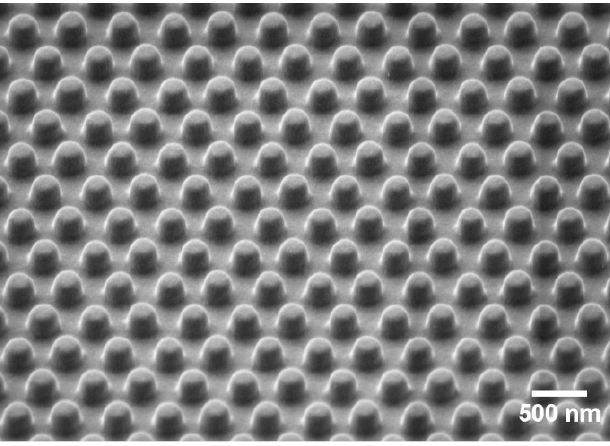
Figure 1. Scanning electron microscope image (SEM) of the nanostructured gold sensor substrate.